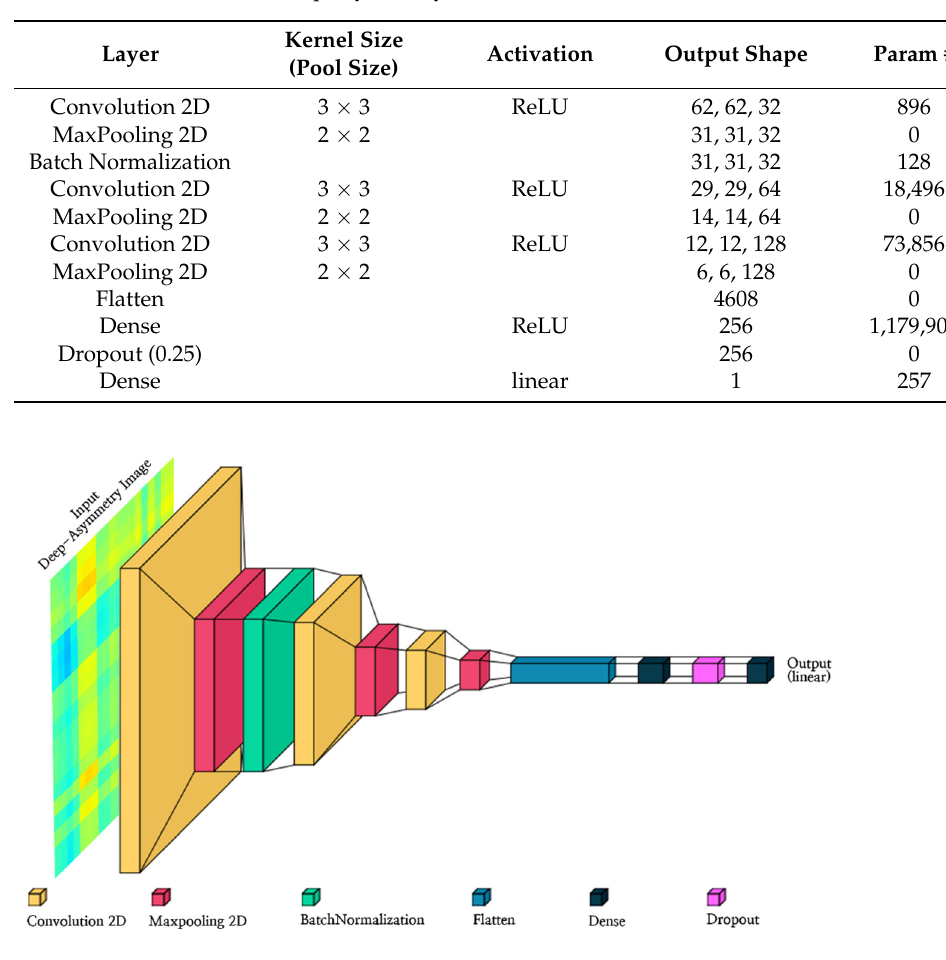
Figure 7. Architecture of a CNN-based regression model that receives deep-asymmetry images.